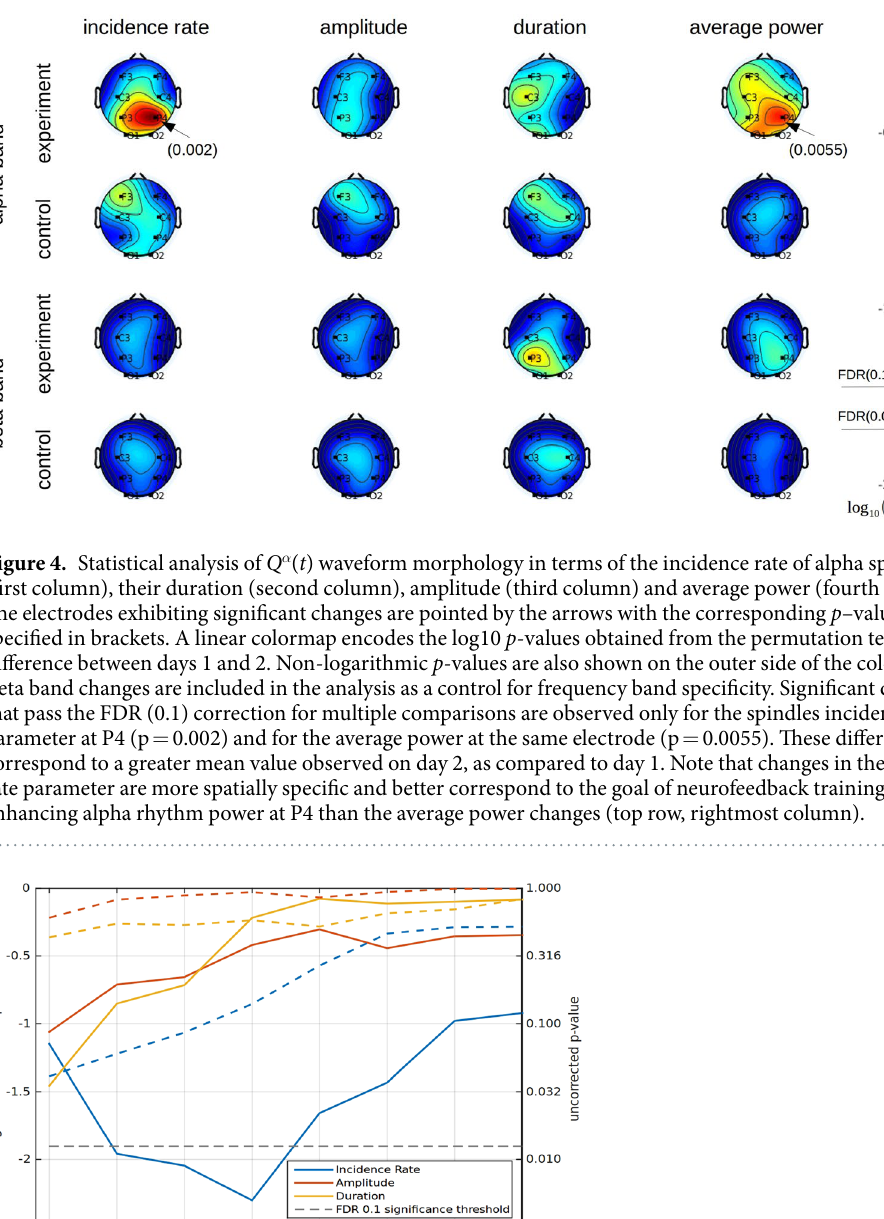
As an additional verification, we tested different thresholds for alpha-spindle detection. We found that the results persisted for a large range of threshold values. Figure 5 depicts the p –values for the three parameters of the EEG at P4 (spindle amplitude, incidence rate and duration) calculated for different threshold values. The dashed lines correspond to the control group and the solid lines to the experimental group. Clearly, alpha-spindle incidence rate enhancement persisted for different threshold values, so this effect was robust to changes in the spindle-detection algorithm parameters. For this purpose, we analyzed the P4 EEG signal in both the experimental and the control datasets using a sliding window (Fig. 6). The analysis utilized the same procedures as for the alpha band, and covered the range of frequencies from 3 to 25 Hz. This analysis showed that the incidence rate changed significantly only for the alpha band, but not for the other tested frequencies; and only in the experimental group.